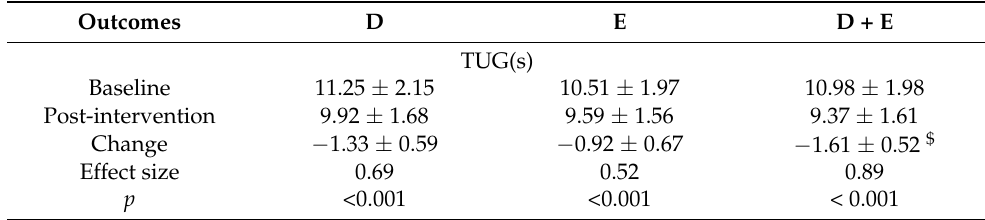
Table 5. Improvements in TUG test after the 12-week